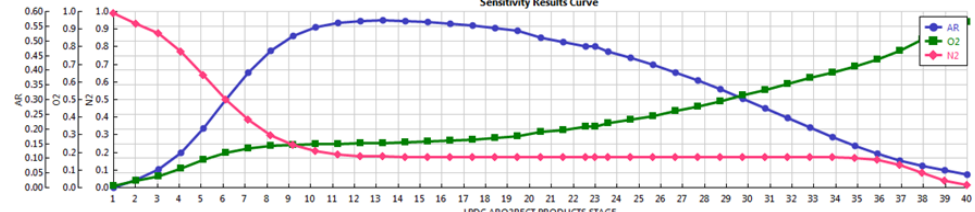
Figure 14. ARO2RECT molar fractions vs. ARO2RECT product stage location in the LPDC.